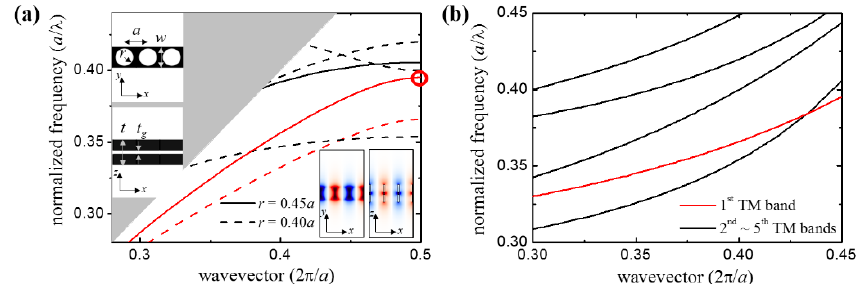
Figure 1. ( a ) Photonic band diagram of the transverse magnetic (TM) modes at the photonic crystals (PhC) nanobeam (NB) with a horizontal air gap. The solid (or dashed) lines correspond to the radius of the air hole at r / a = 0.45 (or 0.40). The left insets show the top and side views of the PhC NB with the air gap. The right insets are the cut-views of the electric field distribution of the first TM mode and the air gap mode at the band edge marked with the red circle. ( b ) Normalized frequencies of the TM band edge mode as a function of the radius of air holes. The red line is the band edge frequency of the air gap